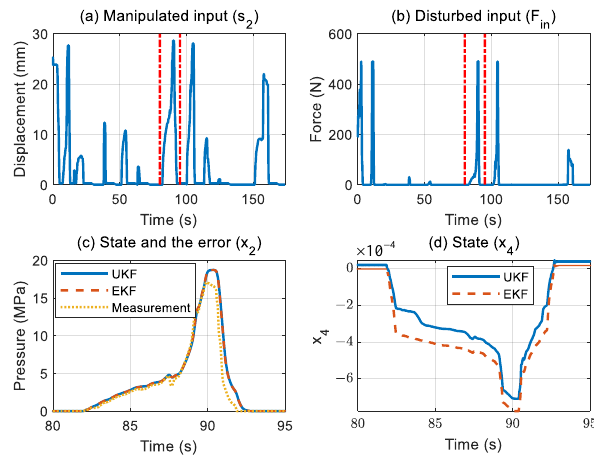
Figure 17. The input and states in vehicle test.